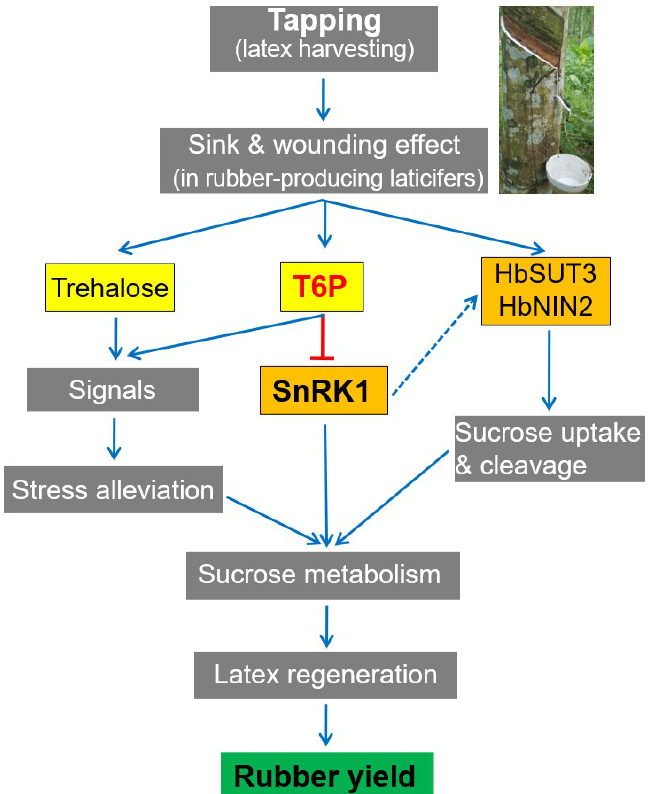
Figure 7. Model for T6P-SnRK1 signaling in harvesting-stimulated rubber production. Tapping incurs sink and wounding effects in rubber-producing laticifers. This increases T6P and trehalose levels and the expression of a sucrose transporter, HbSUT3, as well as an alkaline/neutral invertase, HbNIN2. Elevated T6P functions in at least two ways to enhance sucrose metabolism in laticifers: in activating a ‘feast’ response by inhibiting SnRK1 activity and, together with trehalose, as a signal to relieve water loss stress in a SnRK1-independent manner. The inhibited SnRK1 might also facilitate sucrose uptake and catabolism in laticifers through the induction of HbSUT3 and HbNIN2. The strengthened sucrose metabolism promotes latex regeneration, and thus the rubber yield.